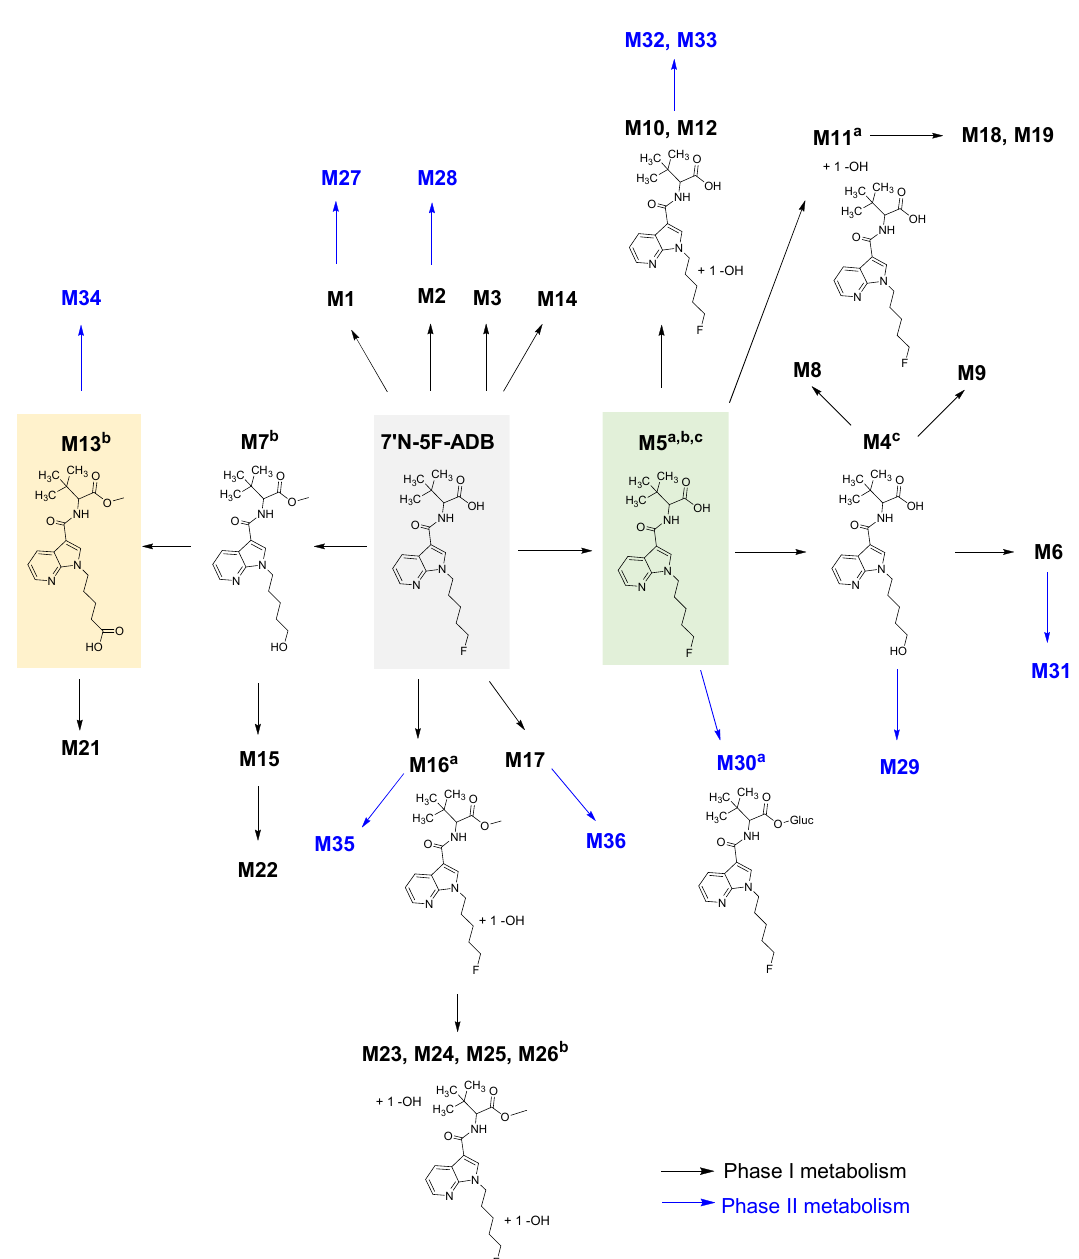
Figure 5. Overview of the reconstructed metabolic pathway of 7′ N -5F-ADB based on the results from all investigated models. The progress of phase I metabolism is represented and the two major metabolites detected in all ZF larvae exposed to 7′ N -5F-ADB, which were M5 and M13, are highlighted by a green and yellow box, respectively. Resulting phase II metabolites are displayed in blue. a Major metabolites in human samples; b major metabolites in microinjected ZF larvae; c major metabolites in HepaRG cells. A schematic representation of the reconstructed pathway from all three models can be found in Supplementary Figure S5.